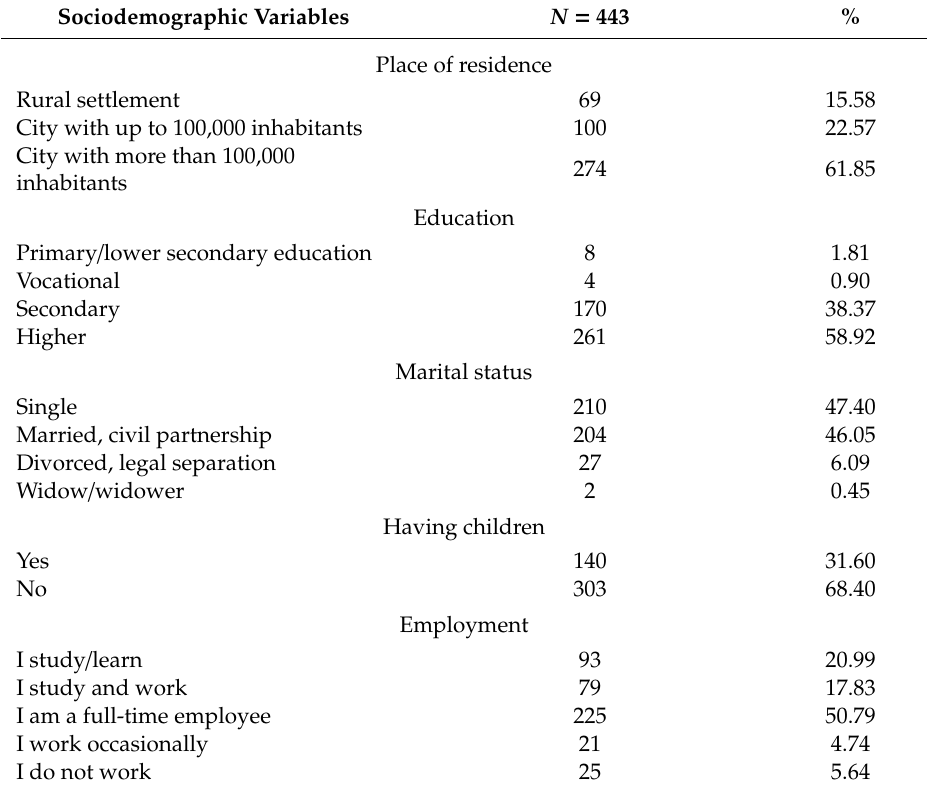
Table 1. Characteristics of the examined group—sociodemographic variables ( N = 443).